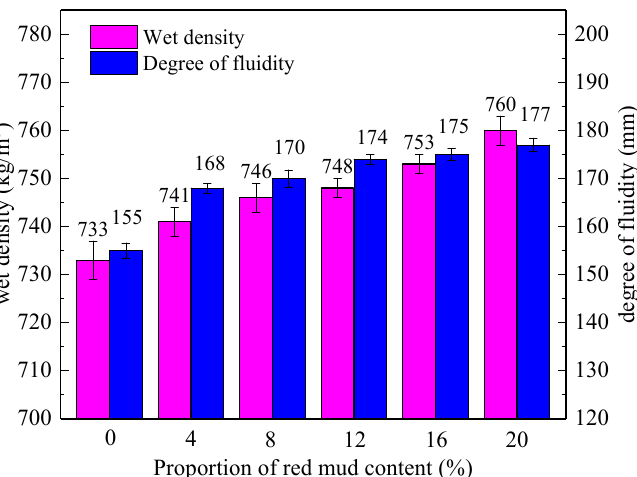
Figure 2. Variation of wet density and fluidity with red mud content.